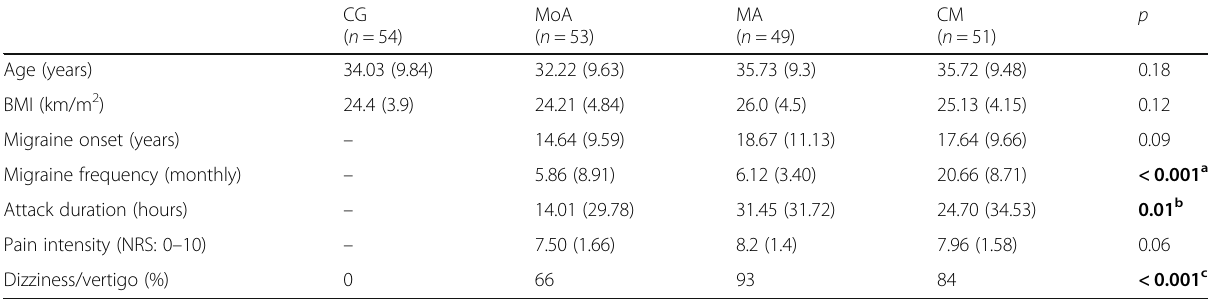
Table 1 Demographic data of the sample. Average data are reported (with standard deviation in parentheses) unless otherwise indicated